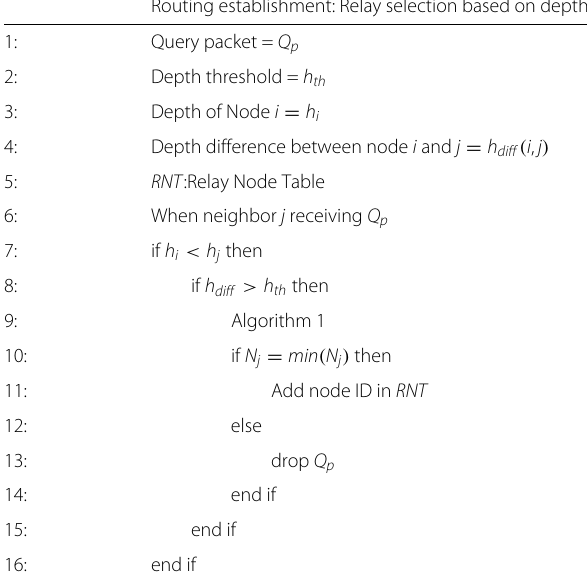
Table 3 Routing establishment of